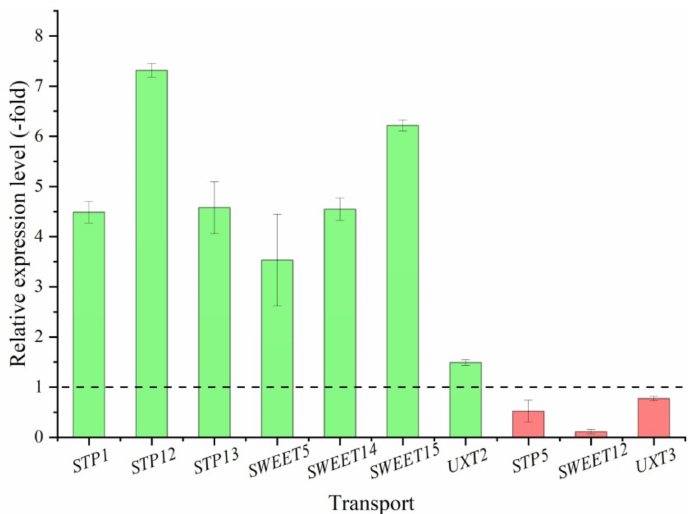
Figure 10. The relative expression level of genes involved in transport in the CR compared with CS, as determined by